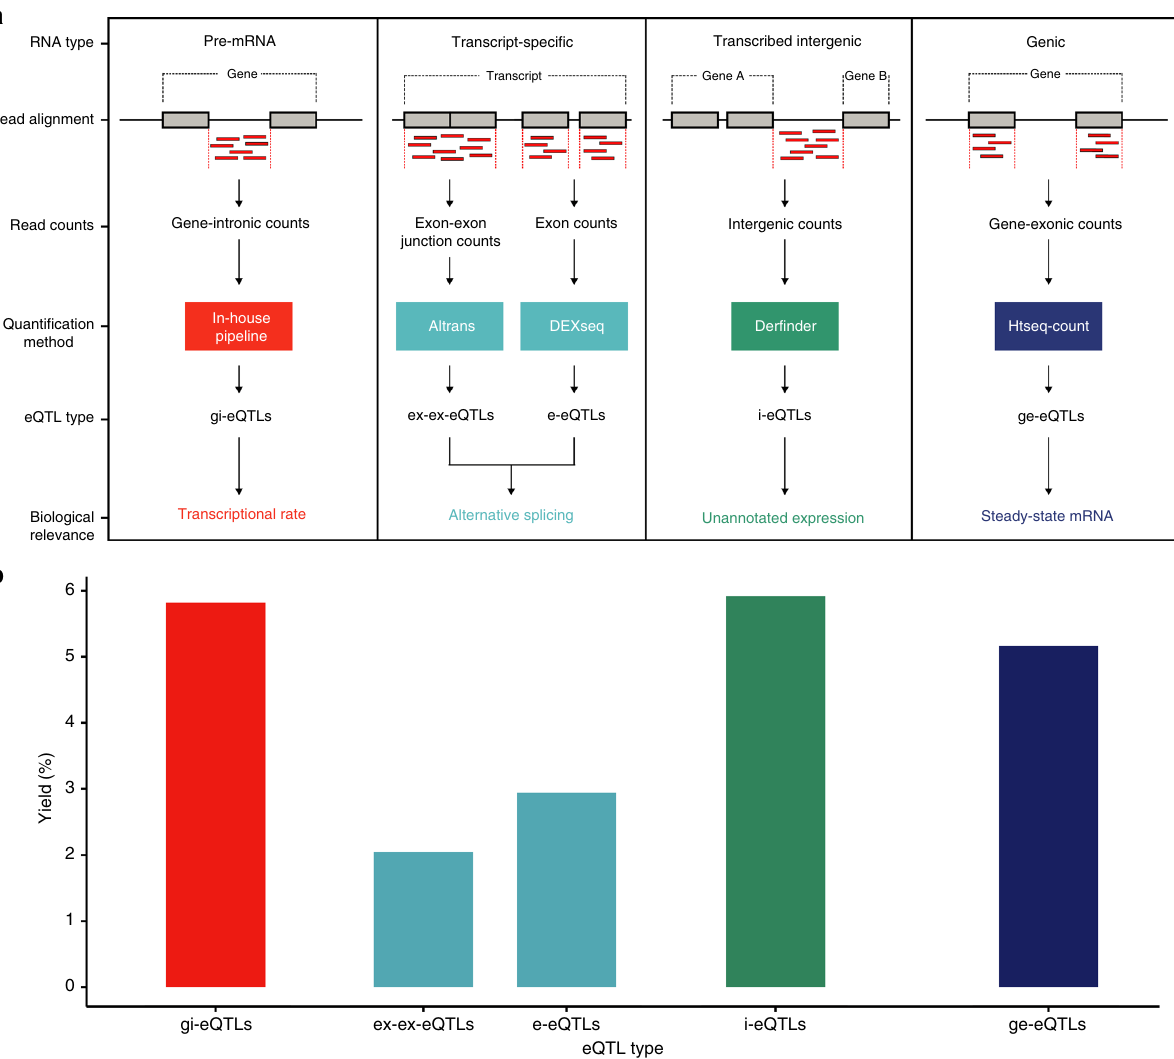
Fig. 1 Similar eQTL yield for unannotated expression features compared with annotated features. a Overview of transcriptome quanti fi cation. RNA was quanti fi ed using fi ve pipelines, each targeting distinct stages of RNA processing, and each followed by eQTL generation. Within annotated regions of the transcriptome, reads were mapped to expression features and thereafter RNA was quanti fi ed. These features included: all intronic and exonic regions of a gene (producing gene-intronic gi-eQTLs and gene-exonic ge-eQTLs, respectively); individual exons (producing e-eQTLs); and exon – exon junctions (producing ex-ex-eQTLs). As total RNA was used for library construction, reads mapping to introns were presumed to be owing to pre-mRNA within samples (an assumption supported by previous analyses using a subset of these data 69 ). Quanti fi cation of individual exons and exon – exon junctions provided a means of identifying loci that impact on alternative splicing. In common with most eQTL analyses, we also calculated overall gene expression using all reads mapping to exons of a given gene, resulting in an expression metric that is in fl uenced by transcriptional rate, splicing and RNA degradation rates. Finally, we included annotation-independent approaches to quantify transcription. We focused speci fi cally on unannotated transcription within intergenic regions (producing i-eQTLs, Online Methods). b eQTL yields for both tissues were calculated as the number of expression features within a category with at least one signi fi cantly associated eQTL divided by the total number of tested features within the same category. Source data are provided as a Source Data fi